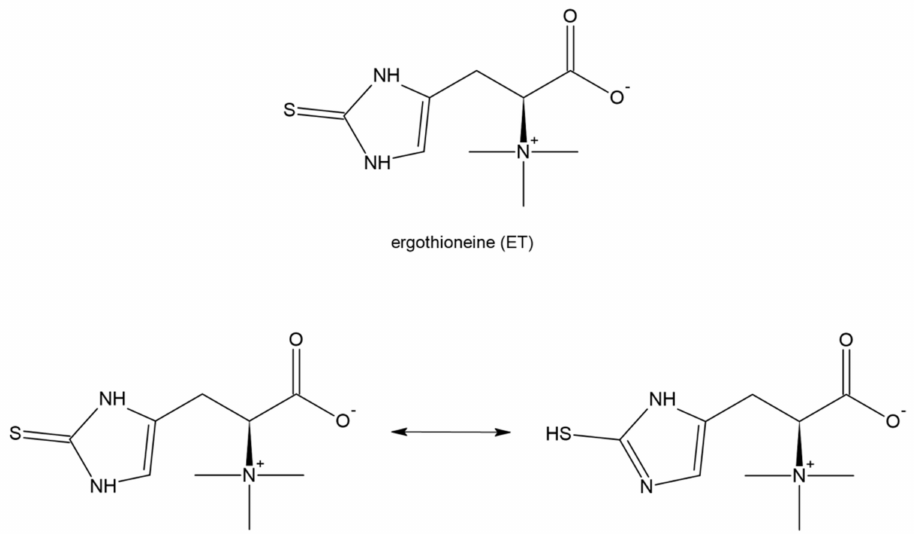
Figure 11. Structure of ergothioneine (ET), namely 2–mercapto-histidine-trimethylbetaine. ET exists in two tautomeric forms: thione and thiol, however, the thione form is prevailing. Recently, the effects of ET were studied in human brain endothelial cell lines treated with 7KC, the cholesterol oxidation product [185]. Endothelial cells are exposed to high levels of 7KC in patients with cardiovascular disease, diabetes, and severe